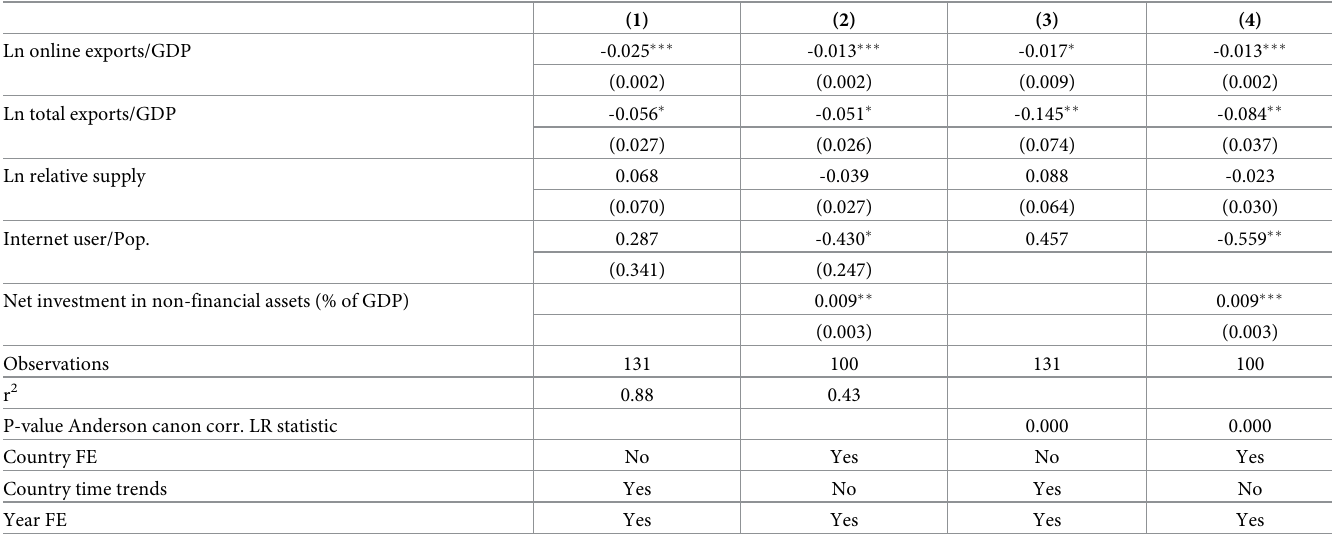
Table 7. Robustness check: Adding country trends, controlling for investment.